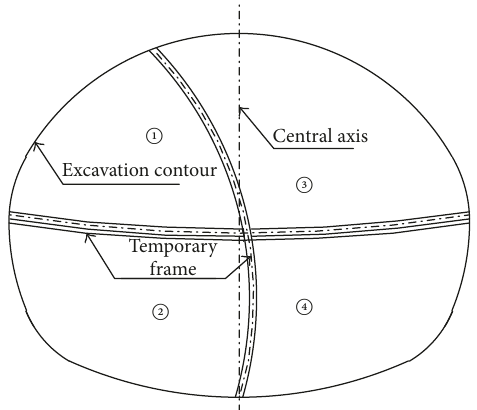
Figure 4: CD method excavation contours for KS3 subway tunnel.